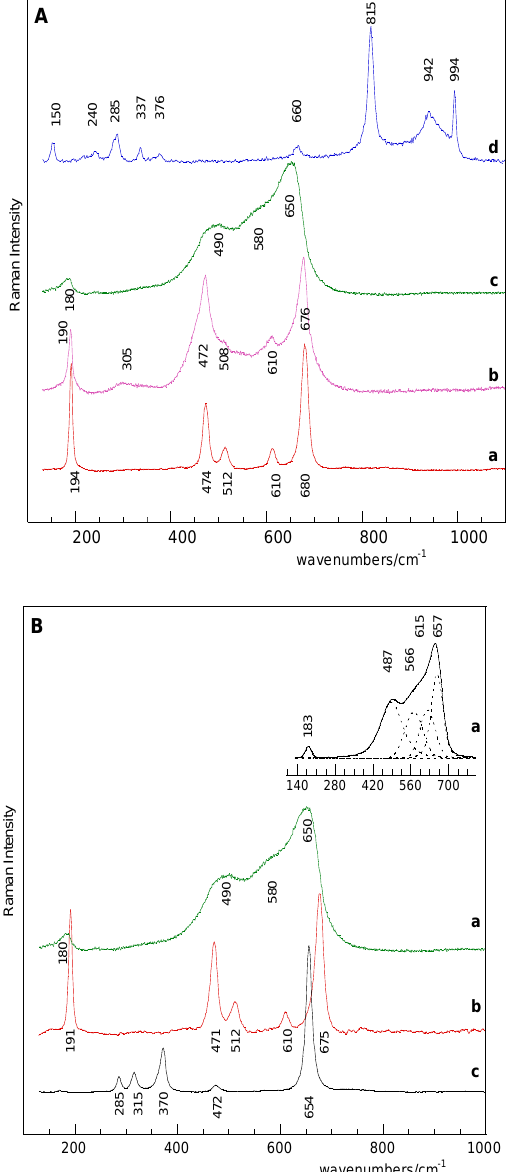
Figure 2. ( A ) Raman spectra of 20CoSiO 2 (a), 10Fe10CoSiO 2 (b) 10Mn10CoSiO 2 (c) and 10Mo10CoSiO 2 (d); ( B ) Raman spectra of 10Mn10CoSiO 2 (a), Co 3 O 4 (b) and Mn 3 O 4 (c) oxides. inset: curve fitting results obtained for the 10Mn10CoSiO 2 sample.